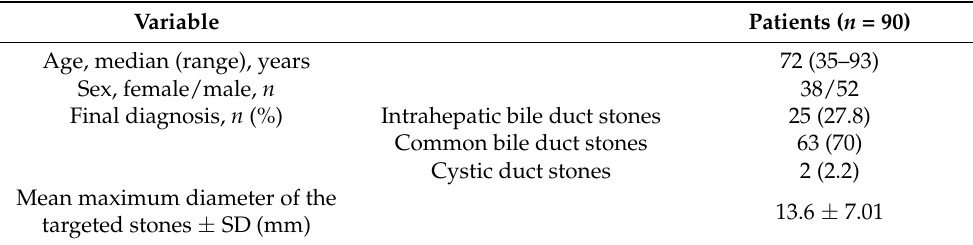
Table 2. Characteristics of patients with difficult bile duct stones. Variable